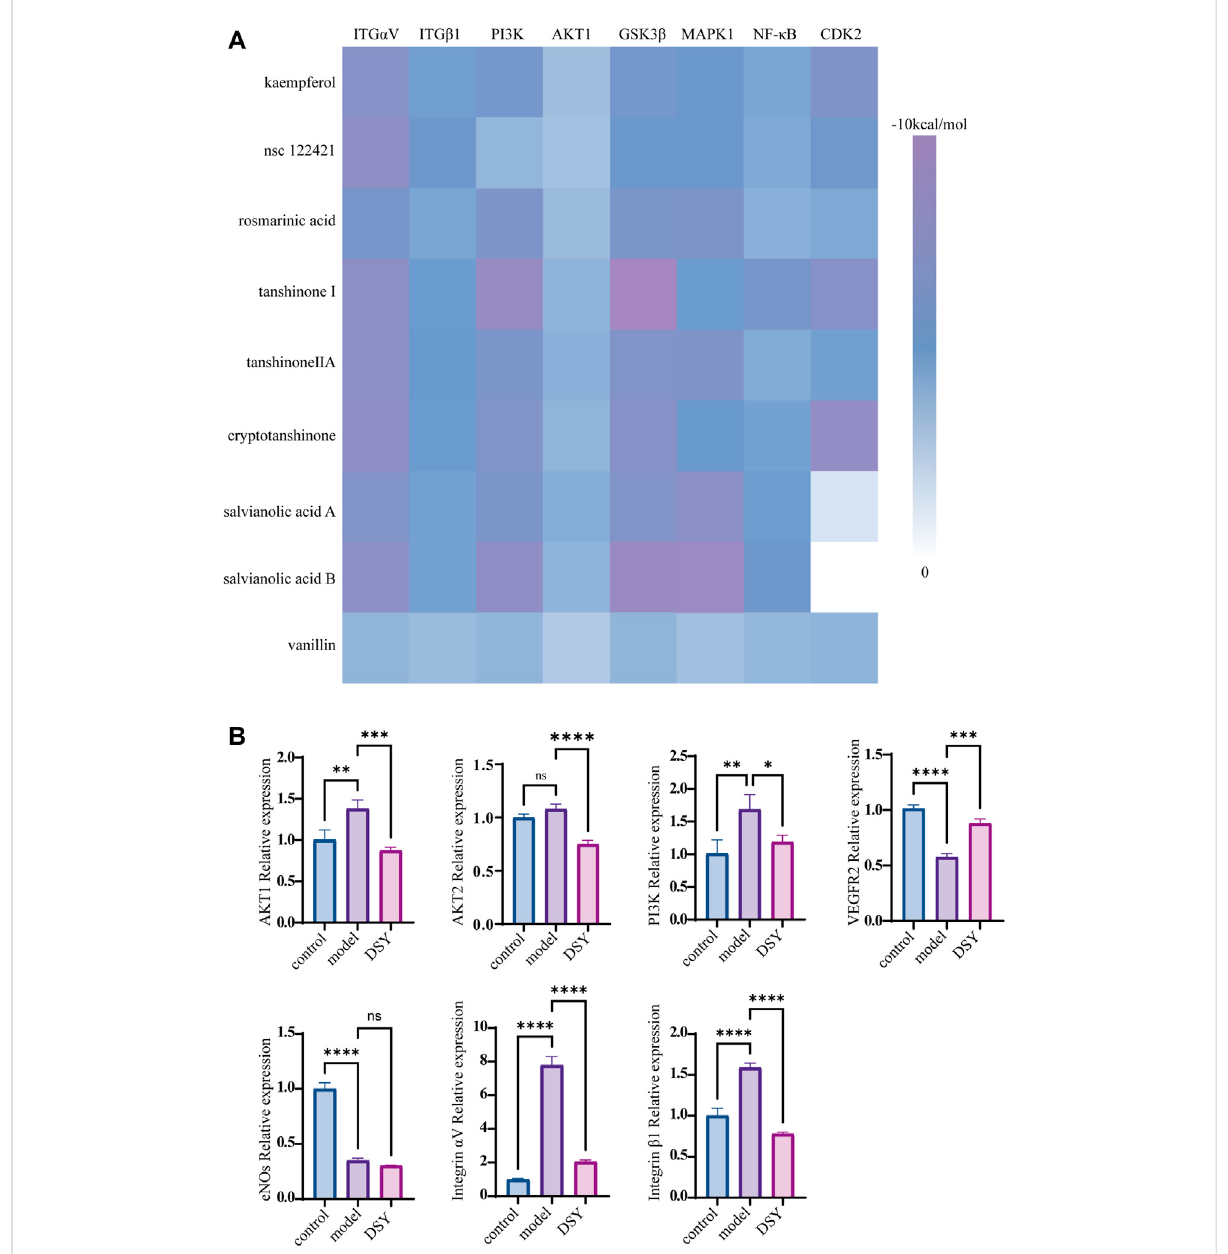
FIGURE 5 ImpactofDSYonPI3K/AKTsignaling. (A) Dockingsimulations